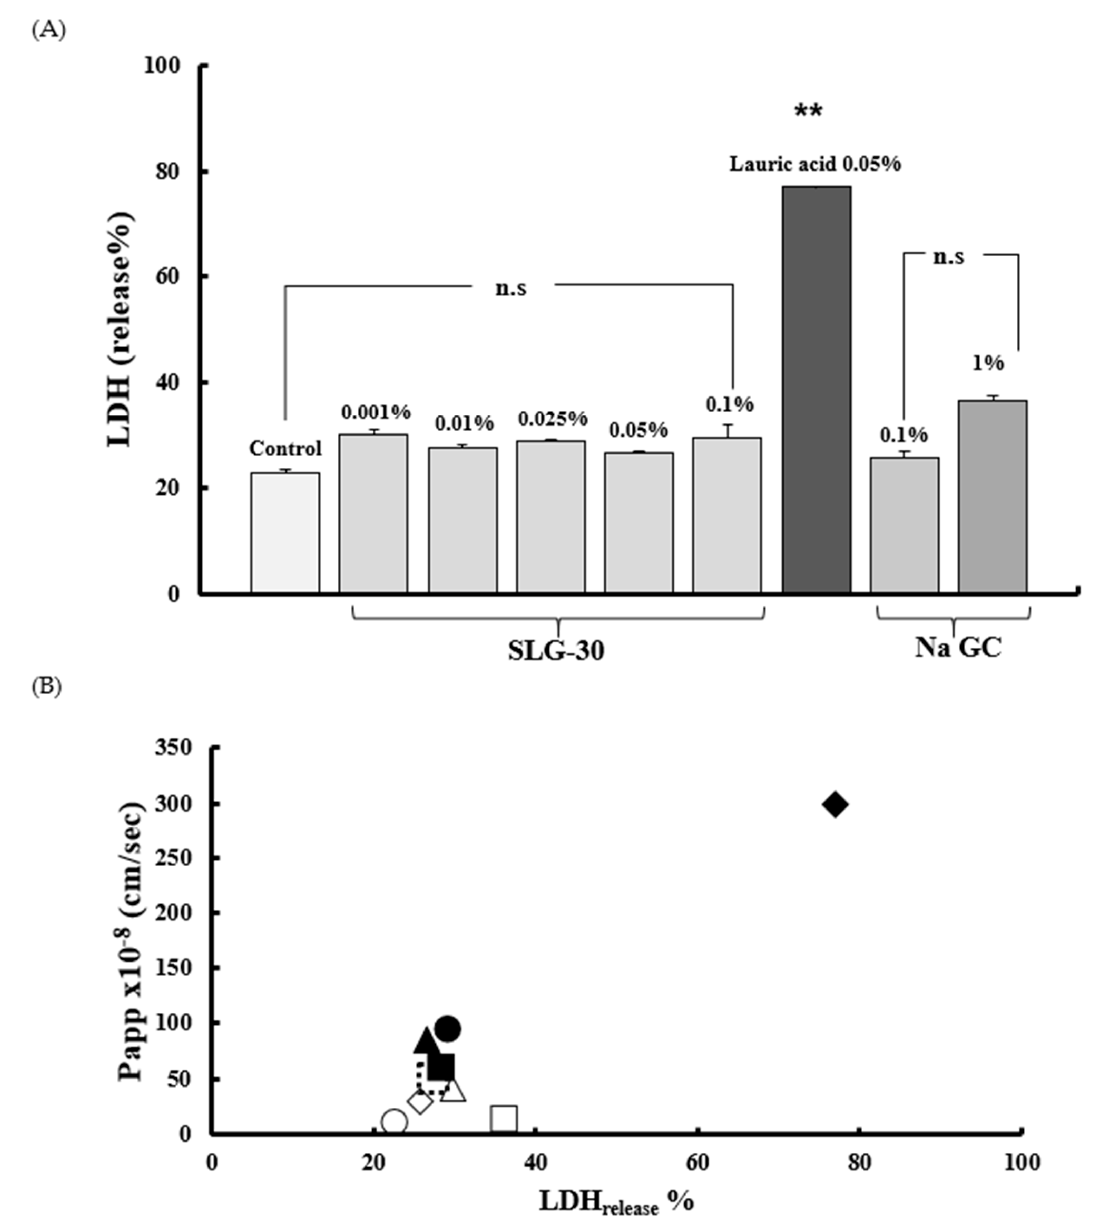
Figure 6. ( A ) The evaluation of the membrane toxicity of Caco-2 cells monolayers in the existence of SLG-30, sodium glycocholate, and sodium laurate and ( B ) the relationship between the effects of SLG-30 and typical absorption enhancers on the CF permeability across Caco-2 cells and their toxic effects: The results are expressed as the mean ± S.E. ( n = 6). ** p < 0.01, n.s. not significantly different when compared with the control. Keys for Figure 6B: ( ◯ ) Control, ( ∆ ) 0.001% ( v / v ) SLG-30, ( ) 0.01% ( v / v ) SLG-30, ( ■ ) 0.025% ( v / v ) SLG-30, ( ▲ ) 0.05% ( v / v ) SLG-30, ( ● ) 0.1% ( v / v ) SLG-30. ( ) 0.1% ( w / v ) sodium glycocholate, ( □ ) 1% ( w / v ) sodium glycocholate, and ( ◆ ) 0.05% ( w / v ) sodium laurate.